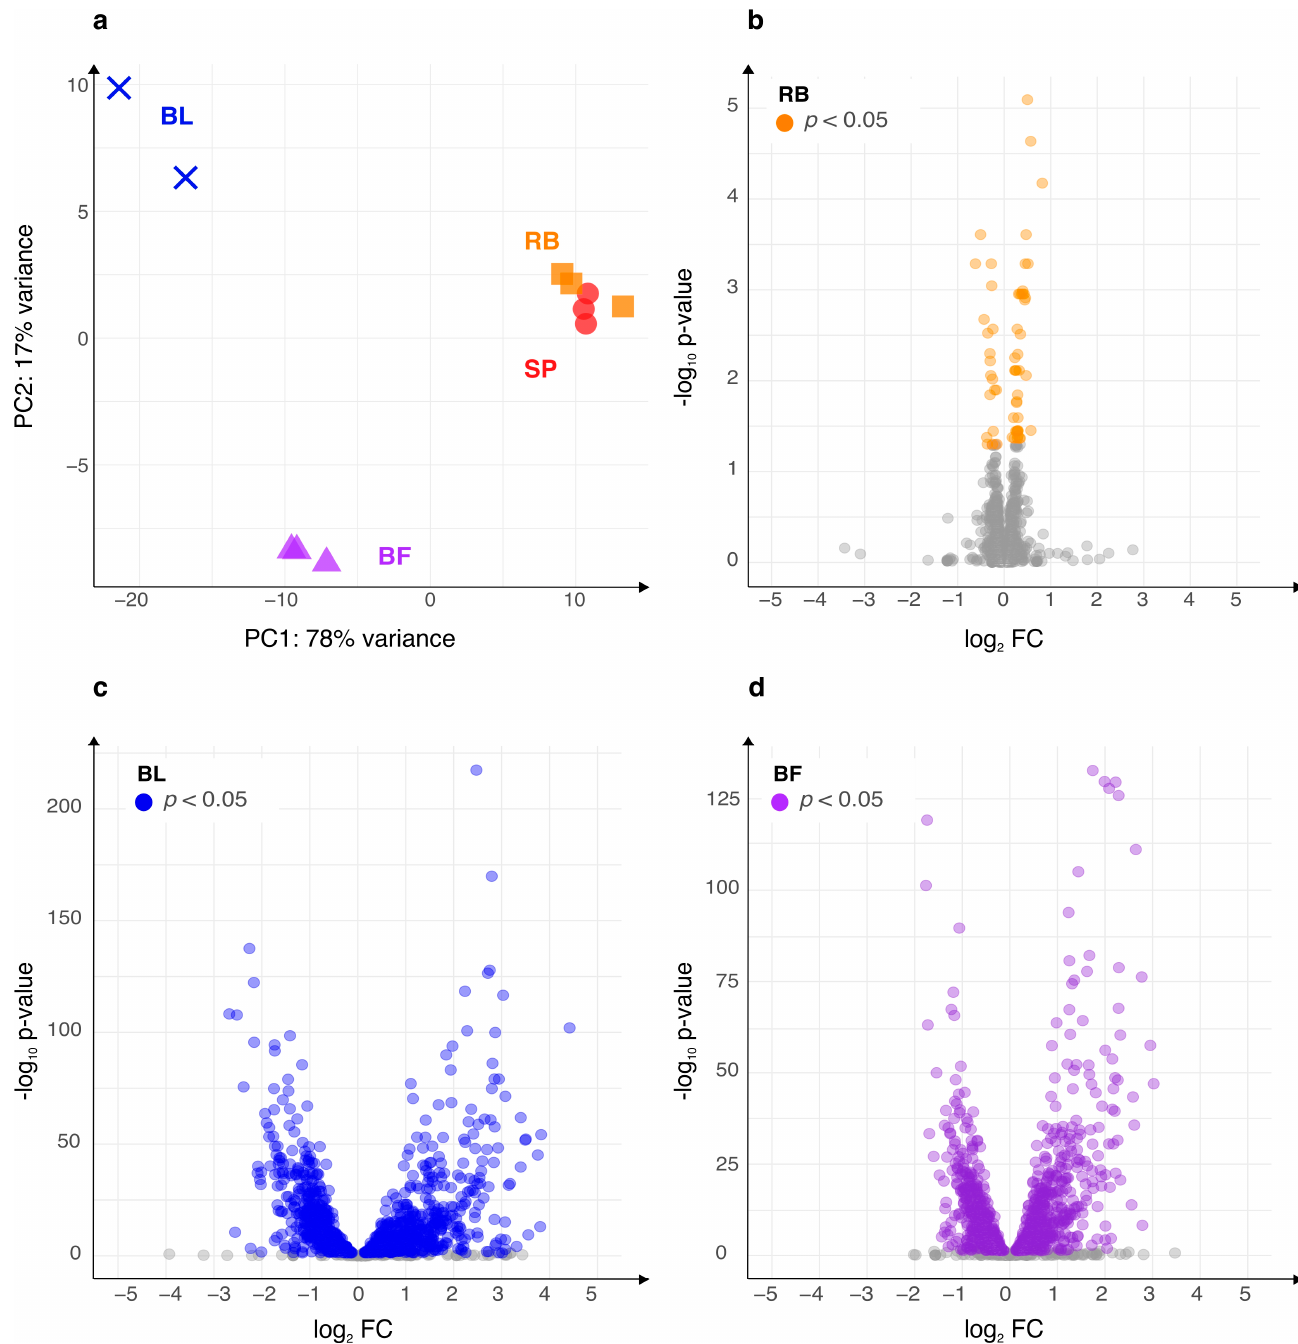
Figure 2. B. burgdorferi morphotypes are showing differential gene expression. Spirochete (SP) and round body (RB) dominated cultures share similar expression profiles, while the bleb (BL) and biofilm (BF) dominated cultures show very distinct transcriptomes. ( a ) Principal component analysis (PCA) of B. burgdorferi B31 morphotype transcriptome data. The replicates have the same color and symbol. Volcano plots show differentially expressed genes in pairwise comparisons: ( b ) the round body (RB) morphotype in comparison to spirochetes, ( c ) the bleb morphotype (BL) in comparison to spirochetes, and ( d ) biofilms (BF) in comparison to spirochetes. Genes that are significantly differentially expressed ( p -value < 0.05) are shown in orange (RB), blue (BL), and purple (BF). Genes that are not significantly differentially expressed are shown in gray. PCA and the significance of differential expressions adjusted for multiple comparisons were calculated using the DESeq2 package.